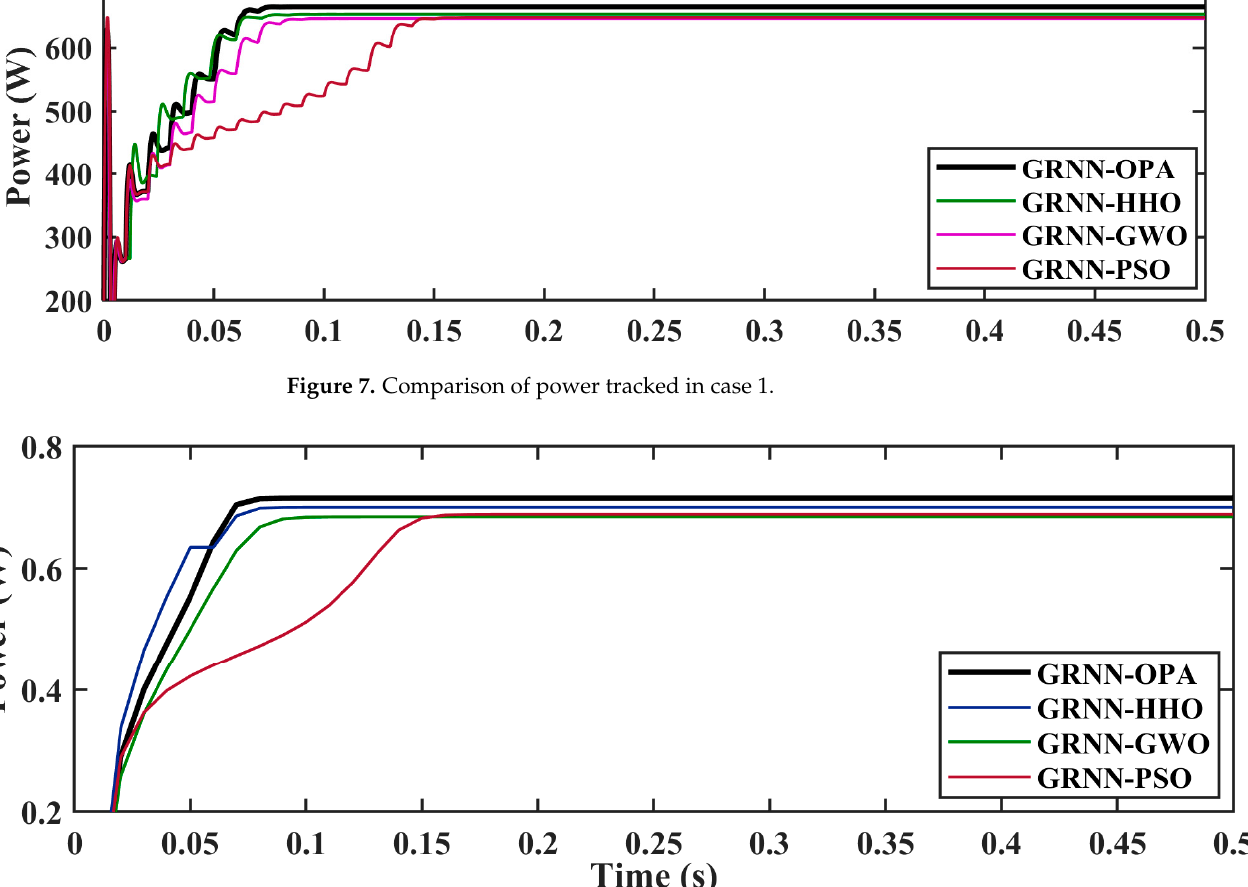
Figure 8. Comparison of duty cycle variation in case 1.